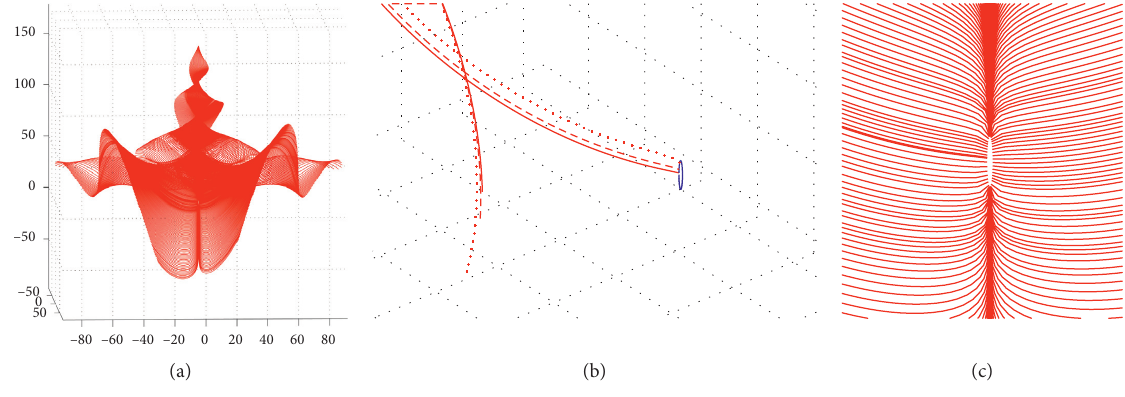
Figure 2: The global manifold and the flows.